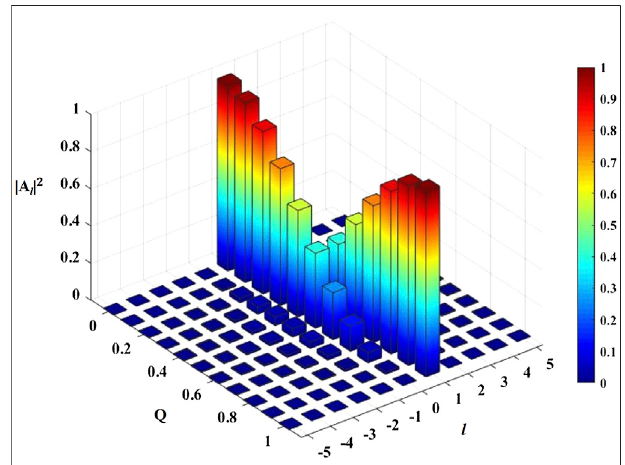
FIGURE 4 | OAM spectra of fractional